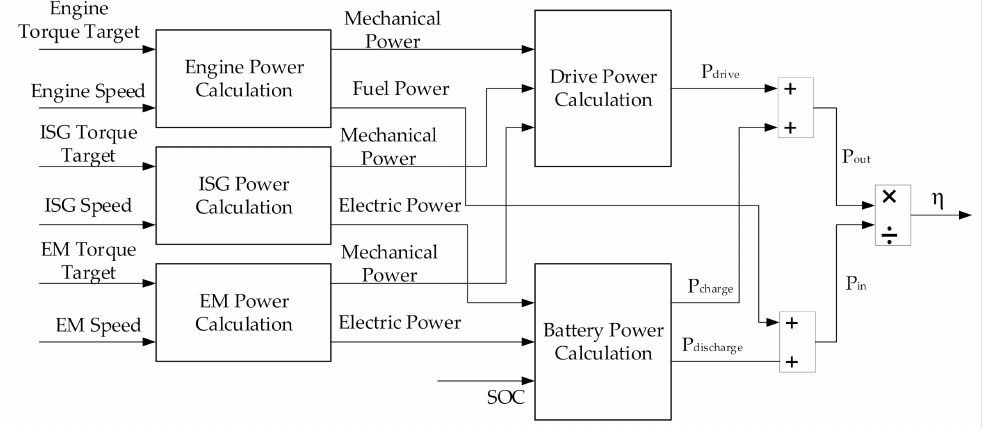
Figure 10. Overall efficiency